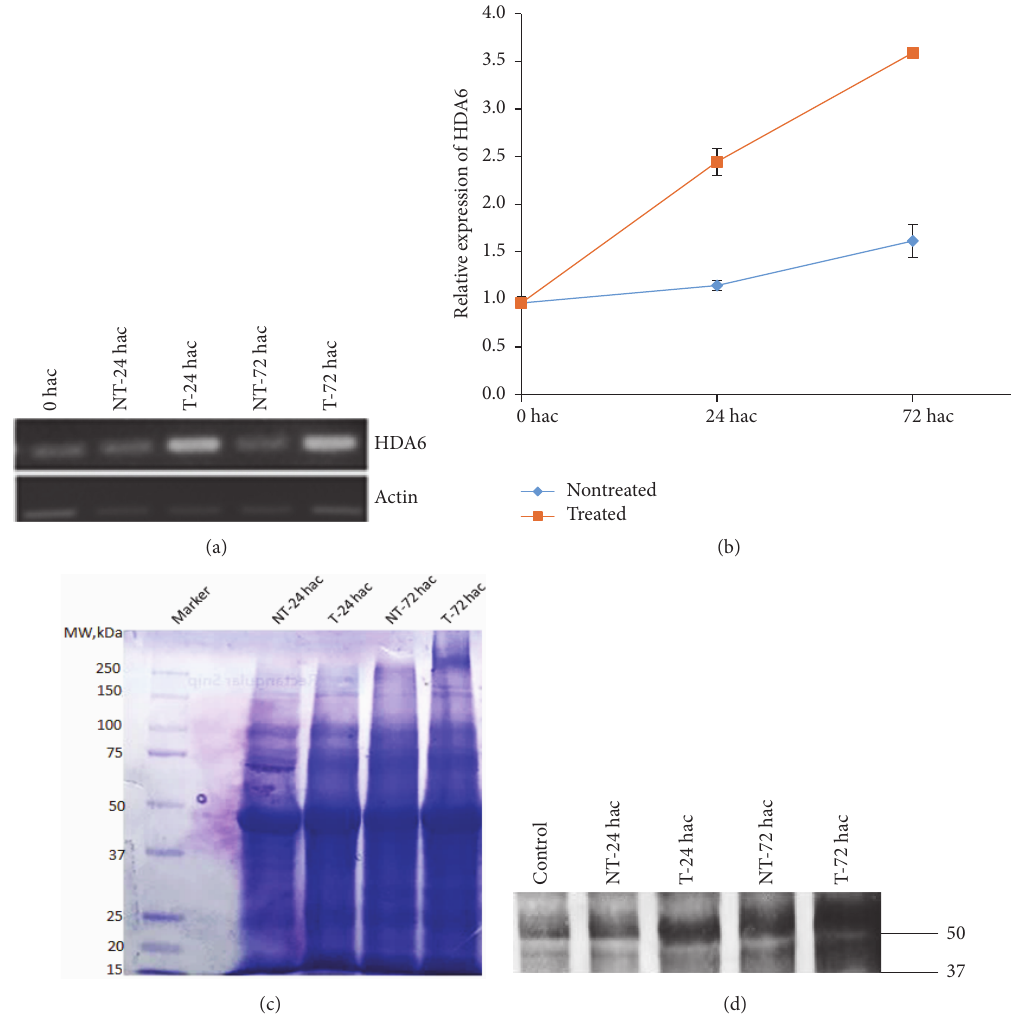
Figure 5: Expression analysis of HDA6 after subjecting common bean plants to cold treatment at 4 ∘ C at different time points. Leaf tissues were collected from control and cold treated plants 24 and 72 hours after treatment. (a) PCR performed after RT-PCR of samples using HDA6 and Actin primers. (b) qPCR to determine relative expression of HDA6 during cold stress. Three biological and three technical replicates were used for the analysis. Data were analyzed by analysis of variance (ANOVA) using [SAS] statistical software. Differences between treatments were assessed by Tukey’s Studentized Range (HSD) Test for experiment. There was significant difference between control and cold treated samples at 𝑝 < 0.0001 . (c) Coomassie stained gel of proteins extracted from control and cold treated samples. (d) Western blot analysis using HDA6 specific antibody with proteins isolated from control and cold treated